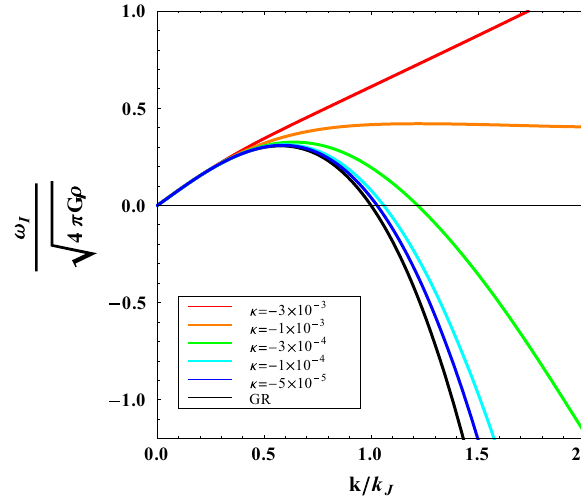
Fig. 1 High frequency limit of growth rate of the Jeans instability. The oscillations of the plasma are quickly damped (as for the Newtonian case)